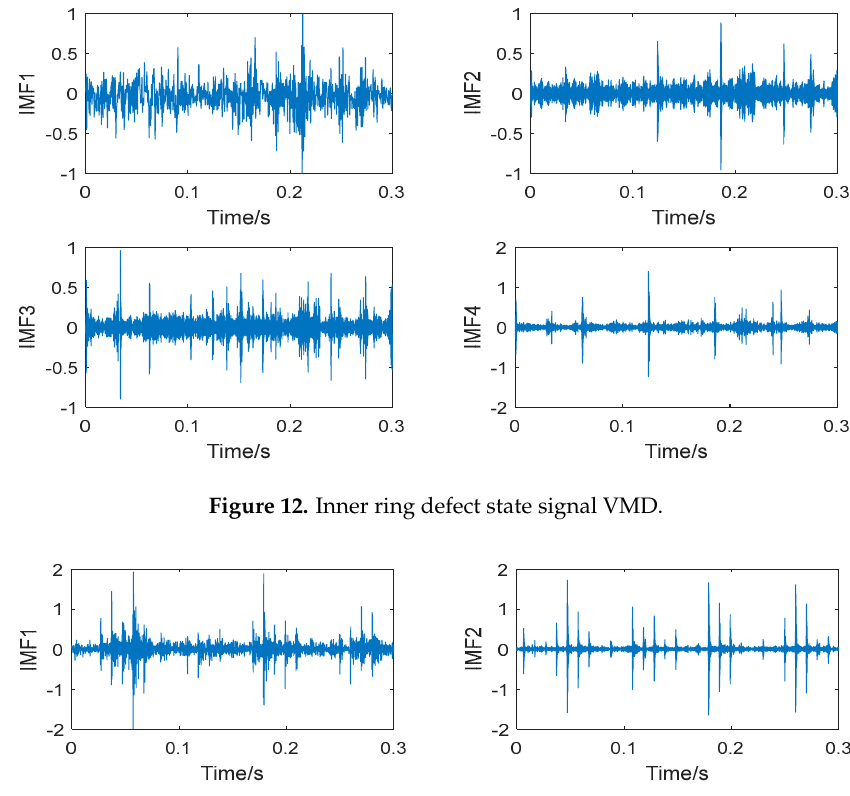
Figure 13. Roller defect state signal VMD. Table 2. Detection index (DI) values of each symptom parameter (SP).